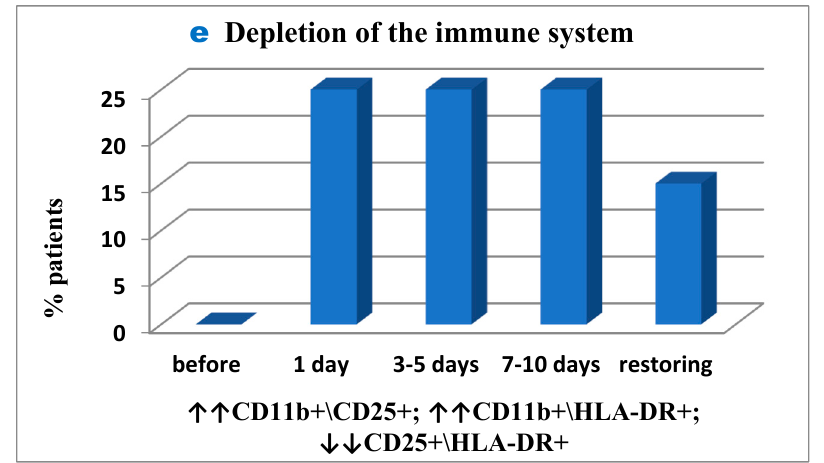
Figure 3. Indicators of enhanced inflammation and migration of T-lymphocytes in patients after cryo-destruction. Legend: T-Lph = T-lymphocytes; number of days = after operation.